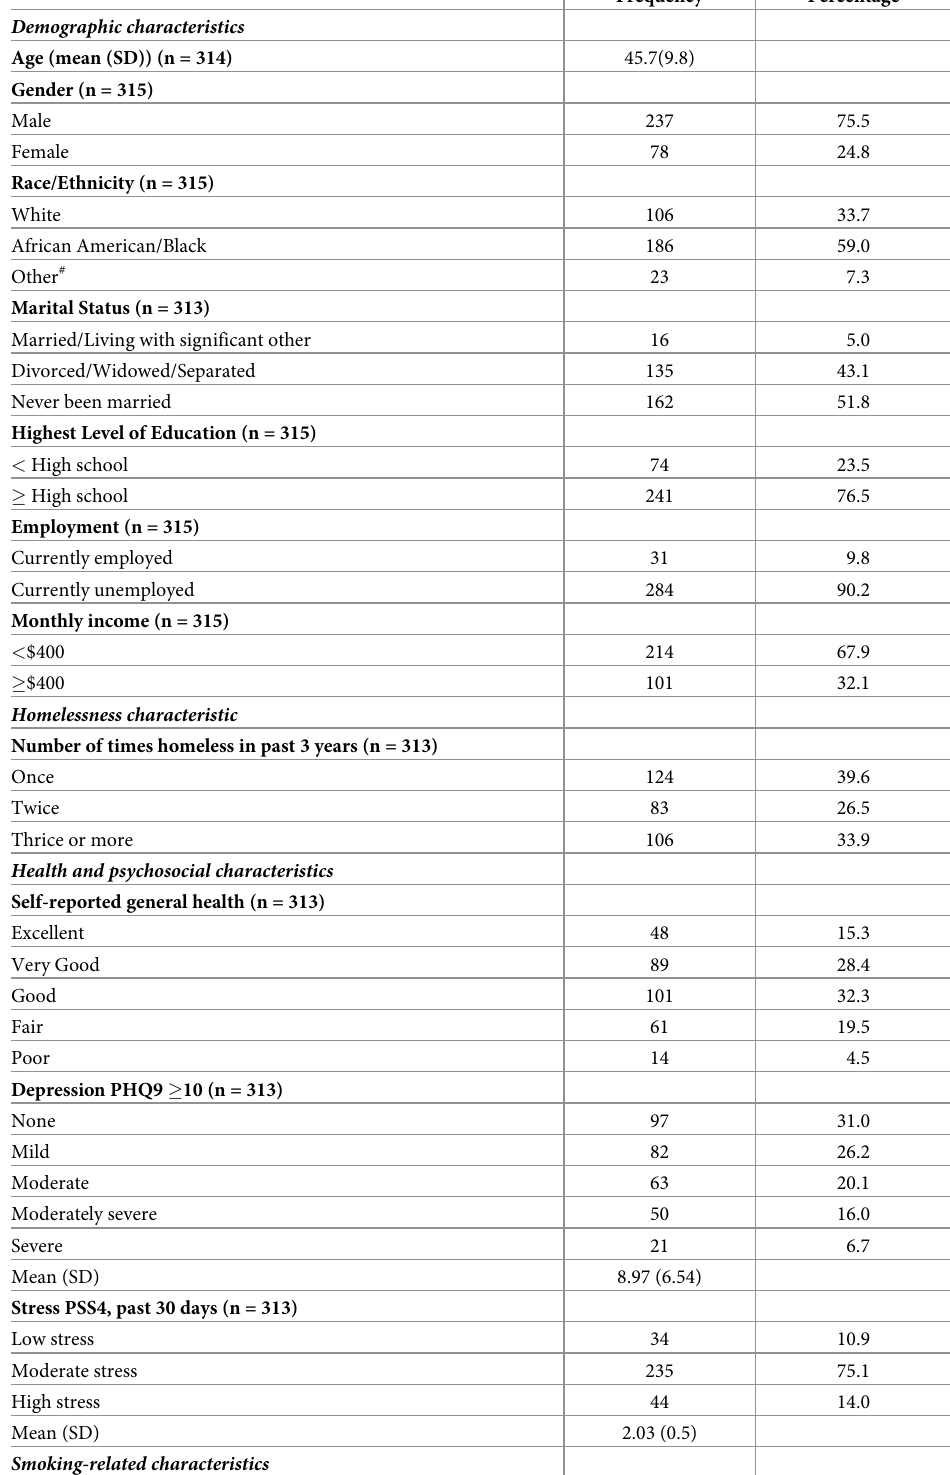
Table 1. Respondents’ demographic, health, psychosocial and smoking related